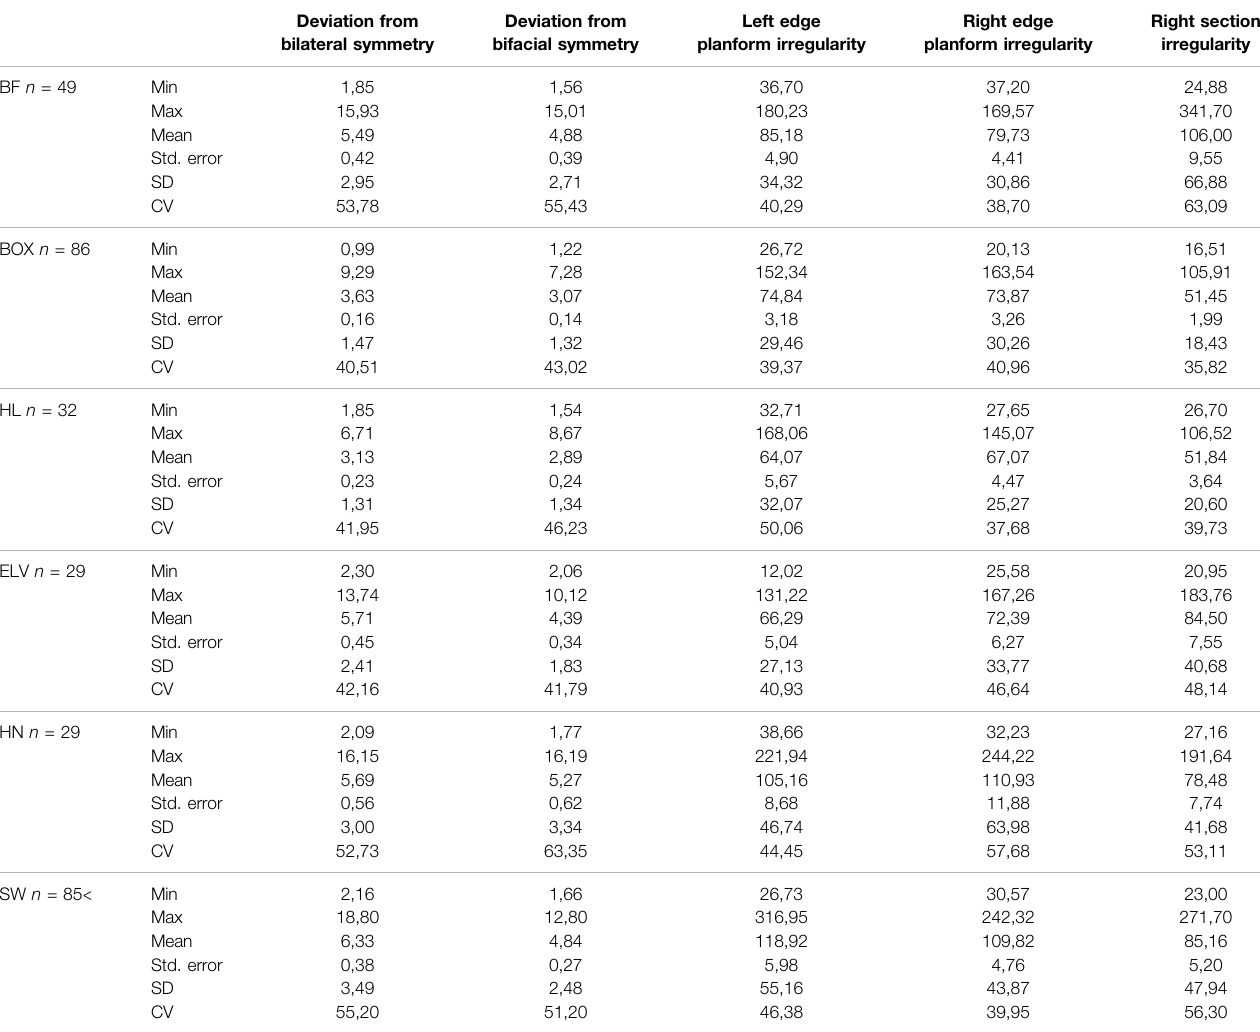
TABLE 4 | Summary statistics for deviations from perfect bilateral and bifacial symmetry and edge irregularity.